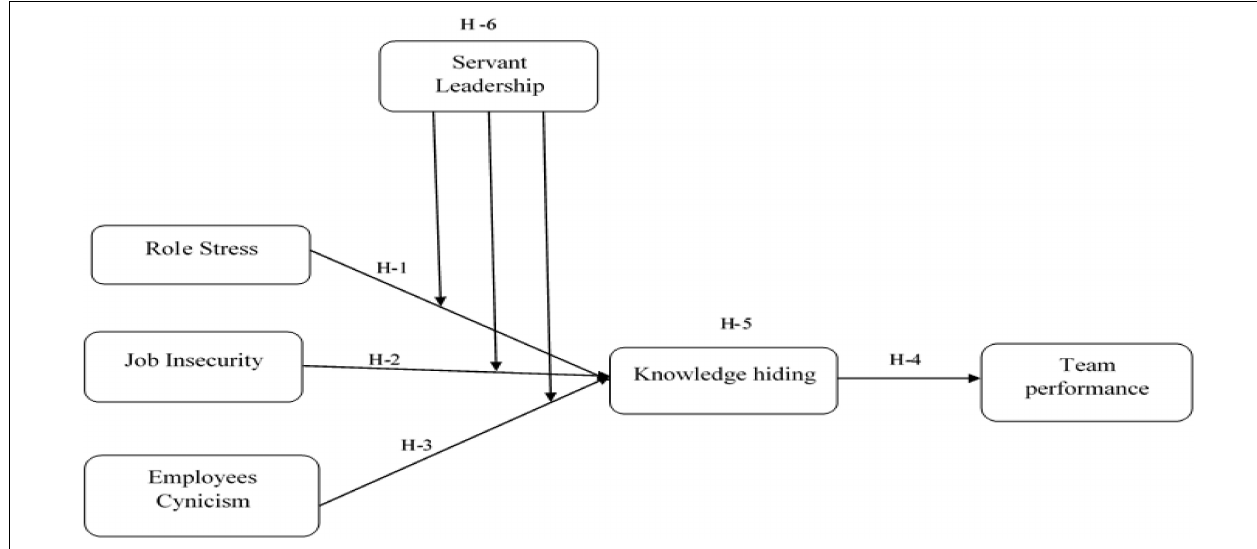
FIGURE 1 | Conceptual